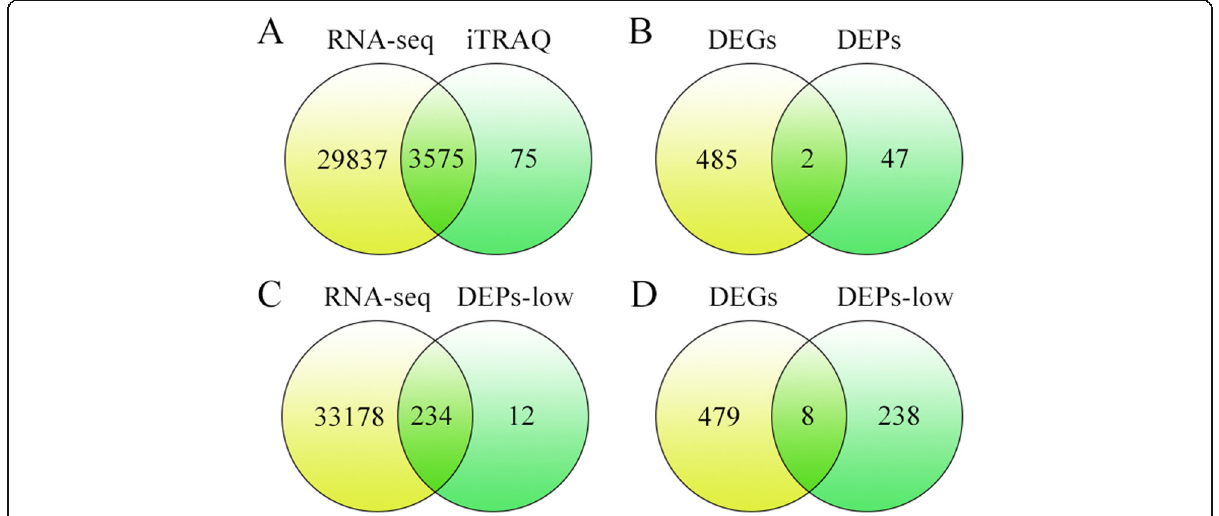
Fig. 5 Correlation between the transcript and protein levels. a , Venn analysis of all expressed mRNA and all expressed proteins. b , Venn analysis of differentially expressed genes (DEGs) and differentially expressed proteins (DEPs) with stringent criteria ( p -value < 005). c , Venn analysis of all expressed transcripts and differentially expressed proteins with less stringent criteria. d , Venn analysis of differentially expressed transcripts and differentially expressed proteins with less stringent criteria